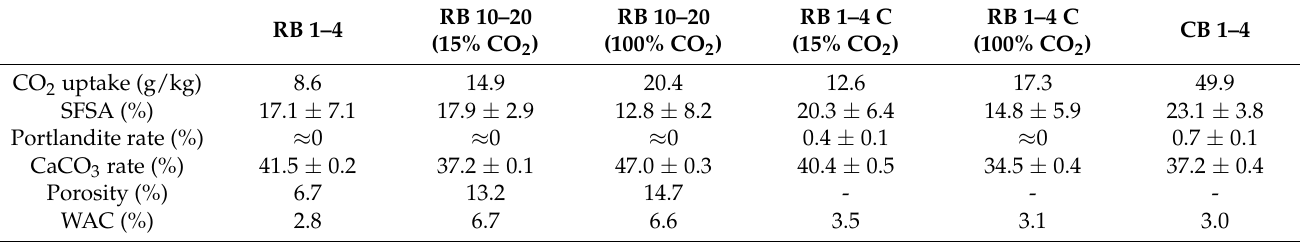
Table 5. Properties of carbonated RCAs (RCAs from demolition